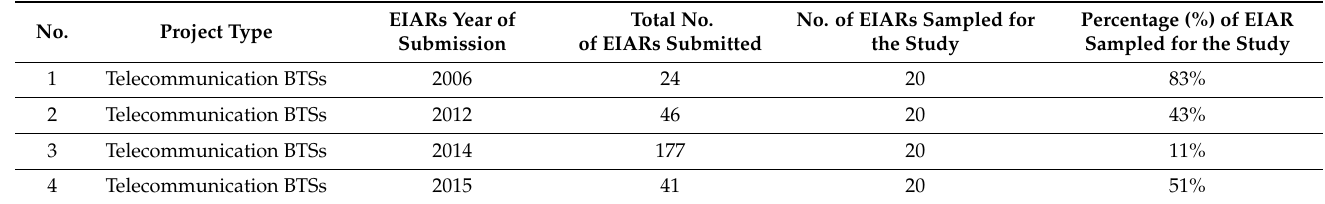
Table 4. EIARs selected for the assessment of